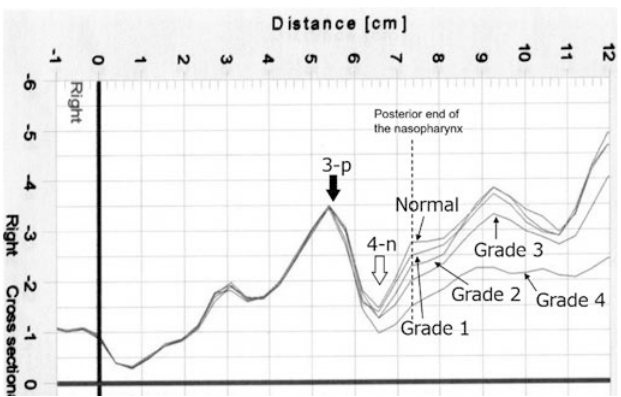
Figure 7 The changes on the area–distance curve by grade of simulated adenoidal hypertrophy. The nasopharyngeal lumen was located between the point immediately after the third peak and the point 8 mm posterior to the fourth notch. Grade 1: 0.4 cm 3 , Grade 2: 0.8 cm 3 , Grade 3: 1.2 cm 3 , and Grade 4: 1.6 cm 3